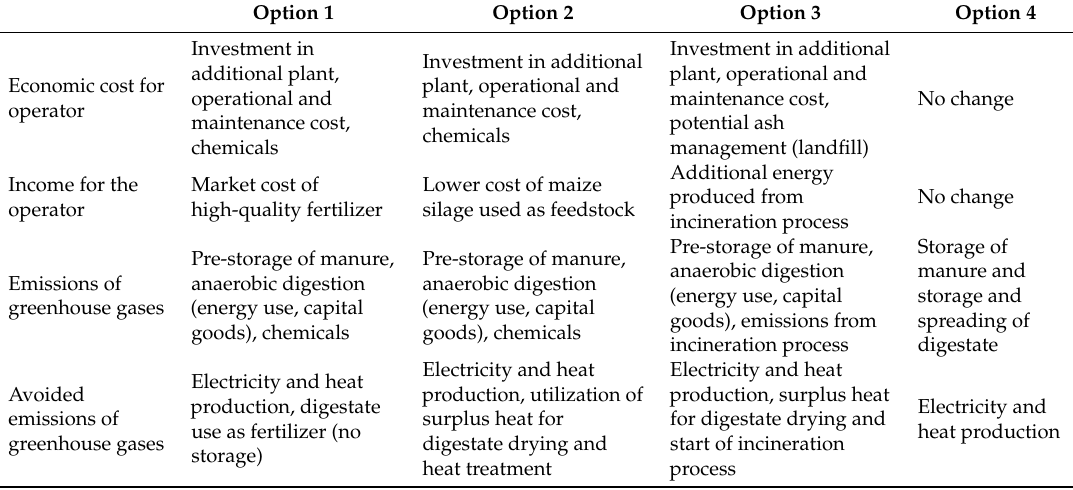
Table 1. Economic costs and income for the biogas facility operator and emissions and avoided emissions for each